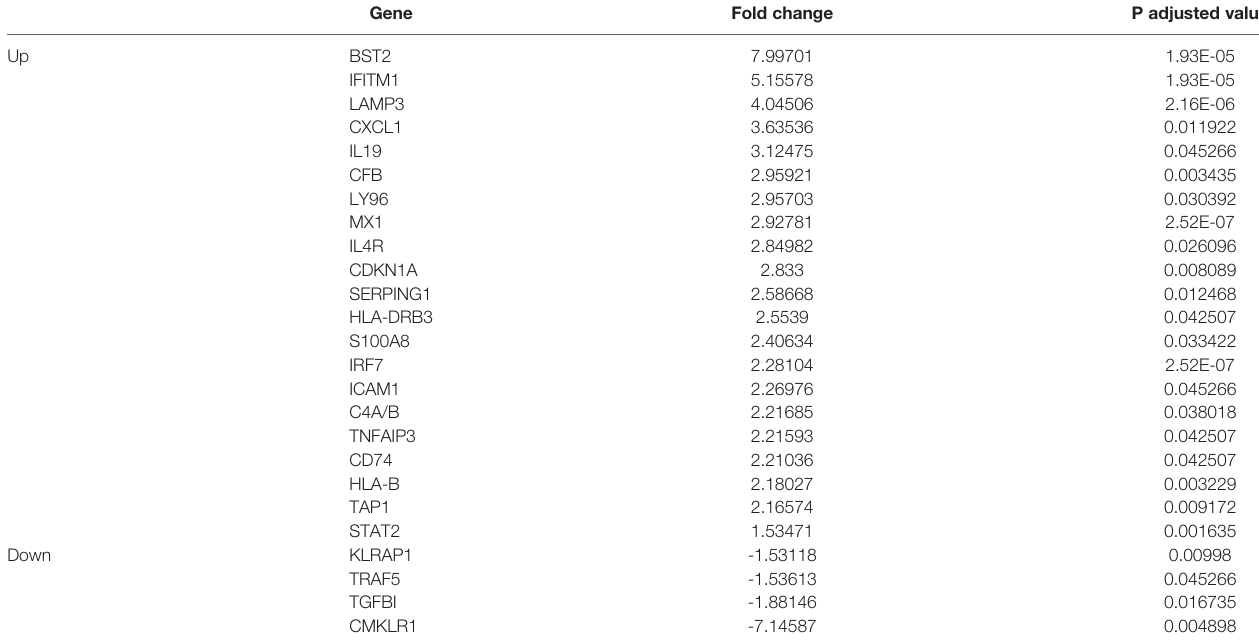
TABLE 3 | Top 20 upregulated and 4 downregulated genes in SS KCS compared to controls.